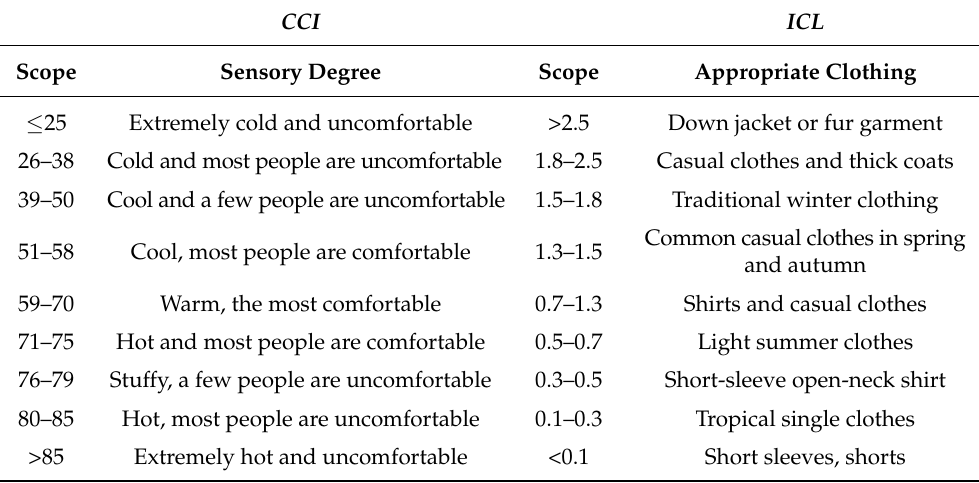
Table 1. Grading standard of the climate comfort index ( CCI ) and index of clothing ( ICL ). CCI